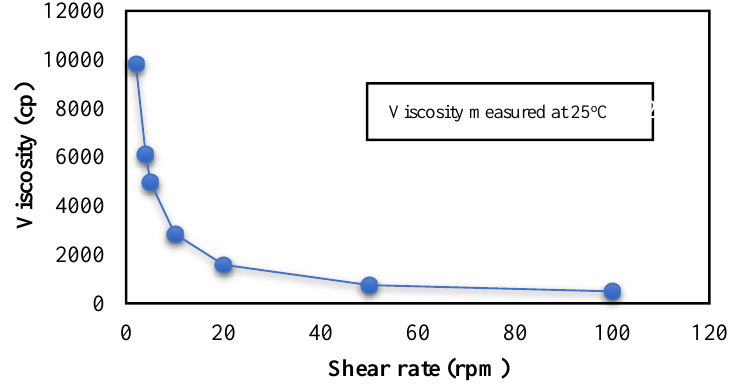
Figure 5. Viscosity of ADA-LP gel measured at 25 °C.